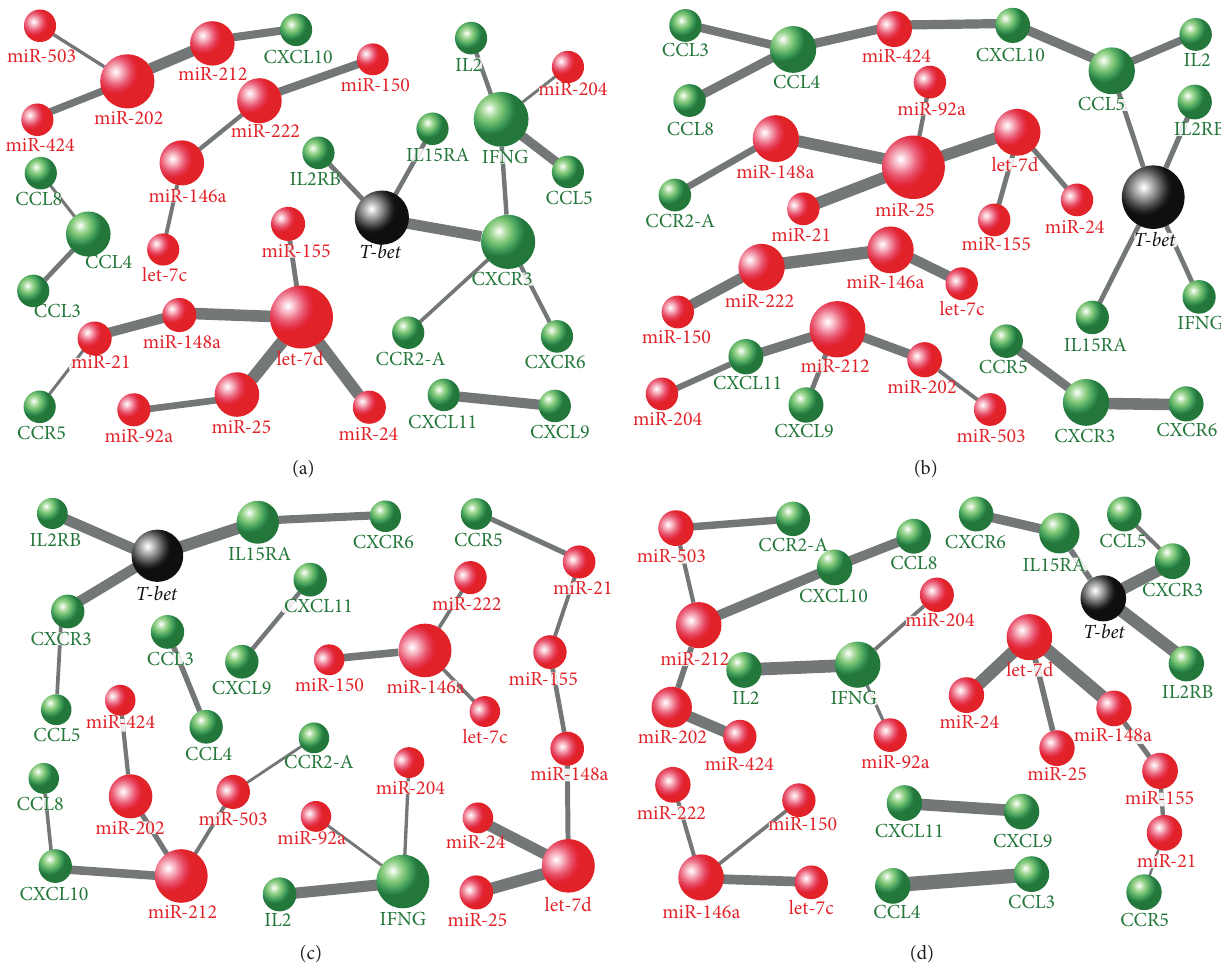
Figure 5: A weighted gene coexpression network analysis of miRNA-mRNA- T-bet relationships in BAL cells obtained from (a) sarcoidosis patients and their subgroups with (b) progressing and (c) regressing disease and from (d) control subjects. The studied molecules are represented as vertices (spheres), where larger vertices in the network have more nearest neighbors than smaller ones. Only edges connecting the nearest neighbors (pairs with the highest correlations) were